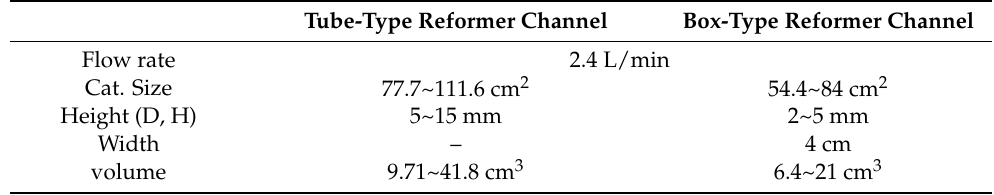
Table 3. Comparison of the box-type reforming channel and the tube-type (methane conversion